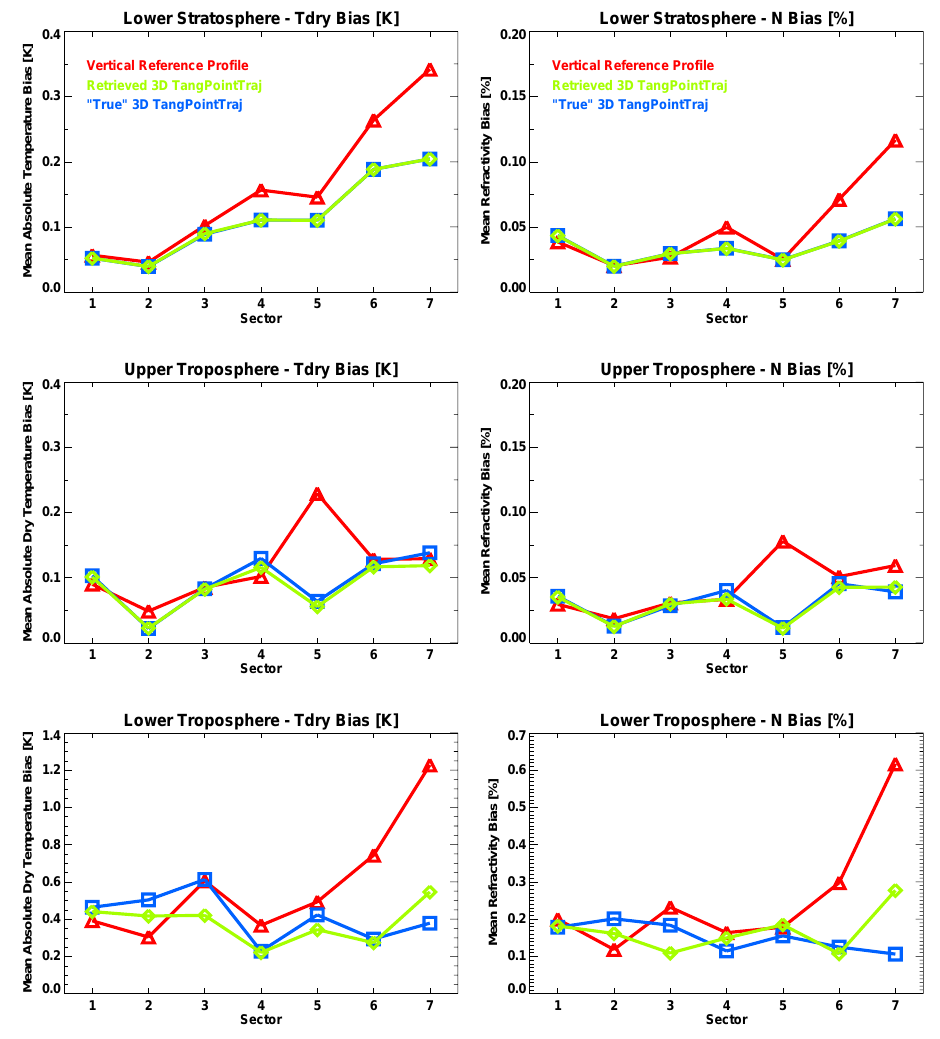
Fig. 7. Mean absolute bias of dry temperature (left) and refractivity (right) in the lower stratosphere between 20km and 25km altitude (top), in the upper troposphere between 5km and 10km (middle), and in the lower troposphere below 5km (bottom; note the different y-axis range).